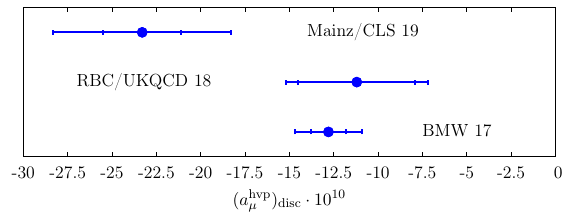
Figure 6. Recent results for the quark-disconnected contribution ( a hvp µ ) disc reported by Mainz / CLS [26], RBC / UKQCD [49] and BMW